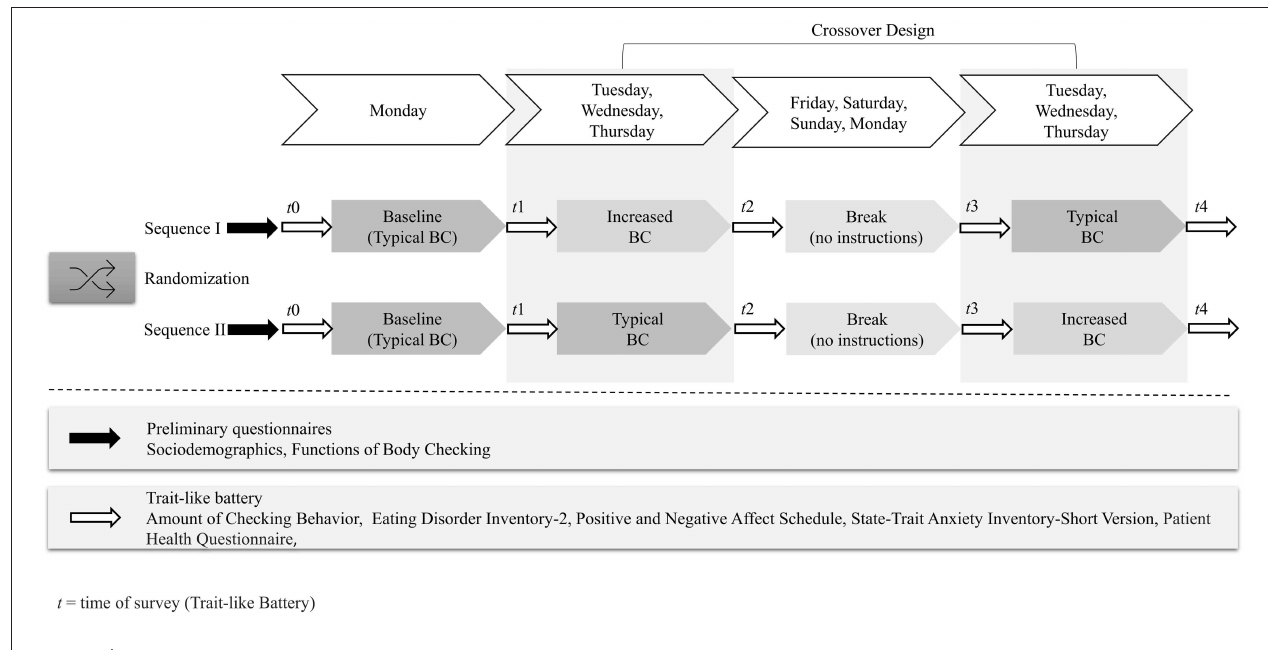
FIGURE 1 | Procedure of the